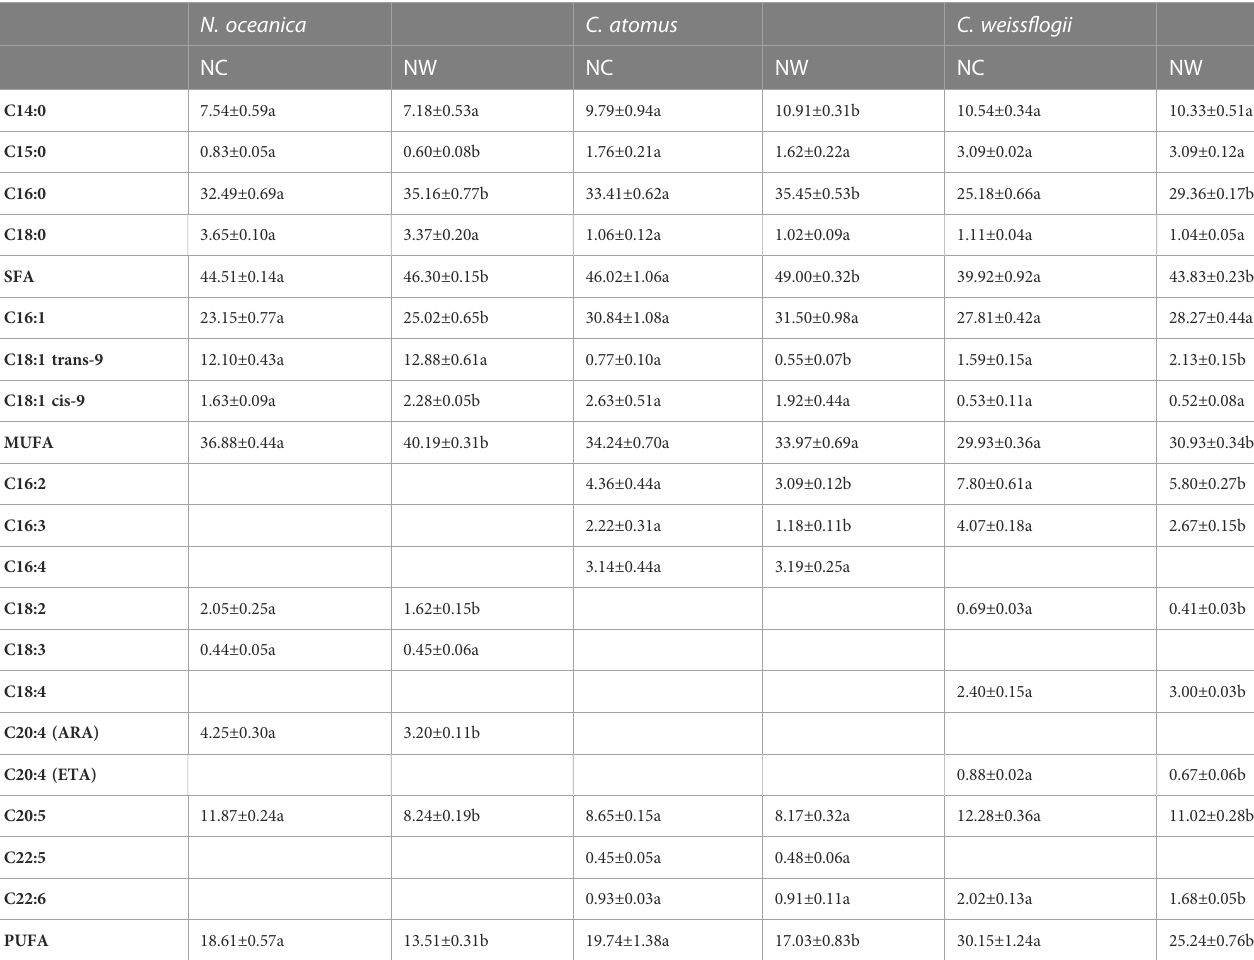
TABLE 2 The fatty acid composition (% of total fatty acids) of N. oceanica , C. atomus , and C. weiss fl ogii under different nitrate-N concentrations. N.